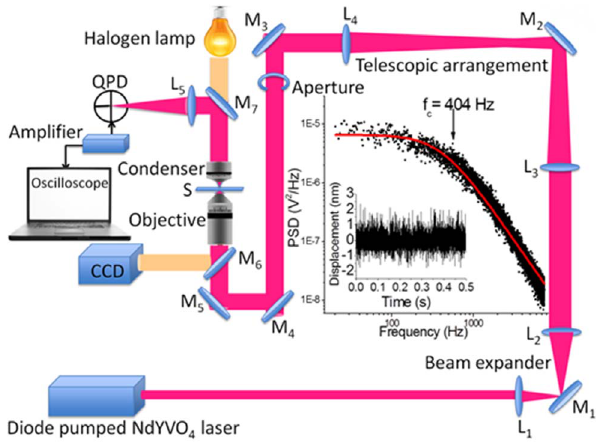
Figure 1. Experimental set-up of our optical trap (see text for details). The graph shows the power spectral density obtained after carrying out a Fourier transform of the displacement of a 2 m m polystyrene bead that is trapped (also shown).